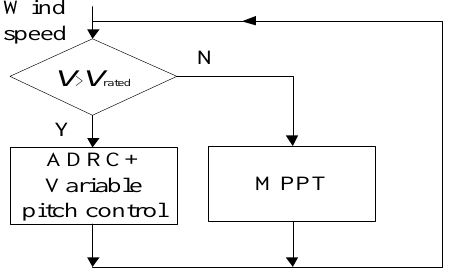
Figure 14. The switching process of the proposed system.